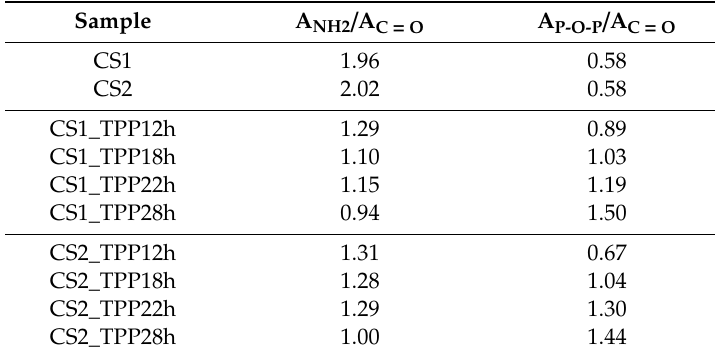
Table 2. Intensity ratios of the absorbance at 1560 cm − 1 (NH 2 ) and 881 cm − 1 (P-O-P) versus the absorbance at 1650 cm − 1 (C = O) for CS_TPP samples.